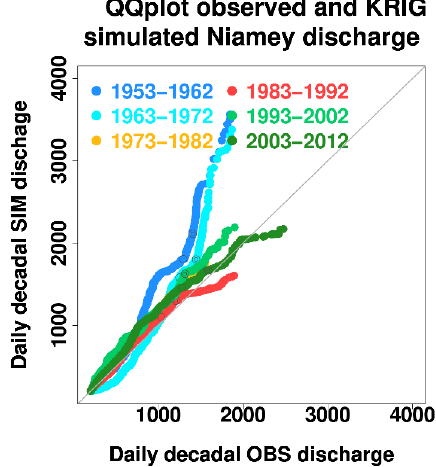
Figure 10. Quantile–quantile plot (Q–Qplot) of the red flood pe- riod distribution of daily discharge of each decade between 1953 and 2012. The x axis is for observations and the y axis for the sim- ulations.